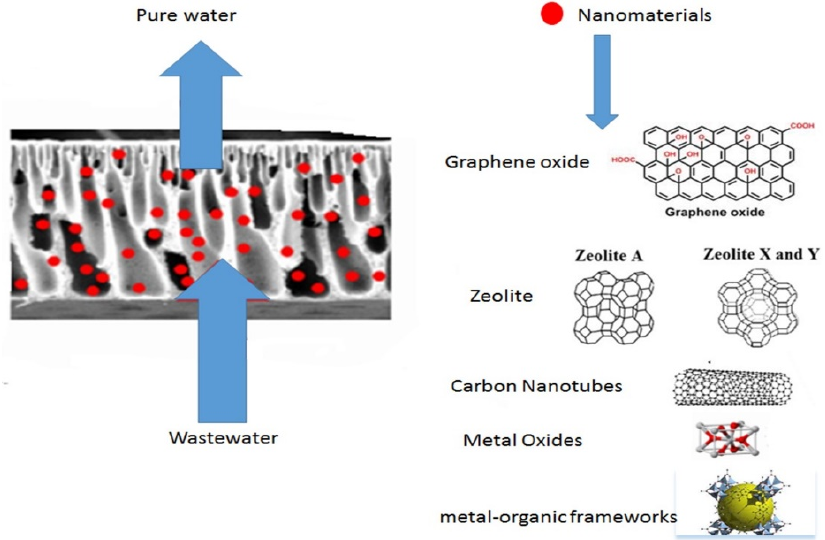
Figure 3. Nanomaterial used for nanocomposite membrane preparation. Adapted with permission from ref. [94]. Copyright 2021 Elsevier.